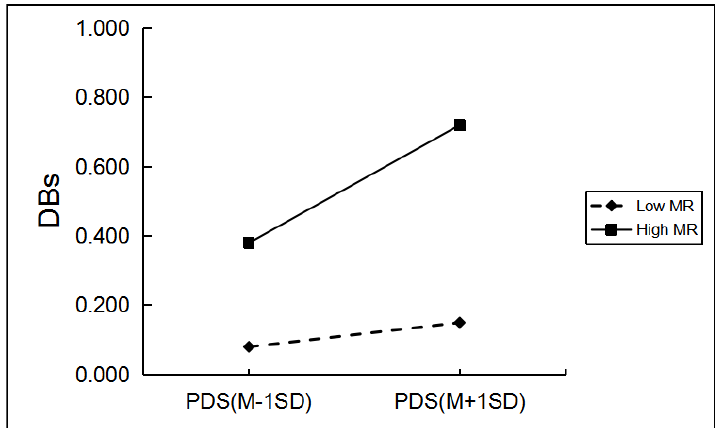
Figure 4. The two-way interaction between PT and MR in predicting girls’ DBs. Note: PDS, the total score of pubertal development scale; MR, mother rejection; DBs, drinking behaviors.